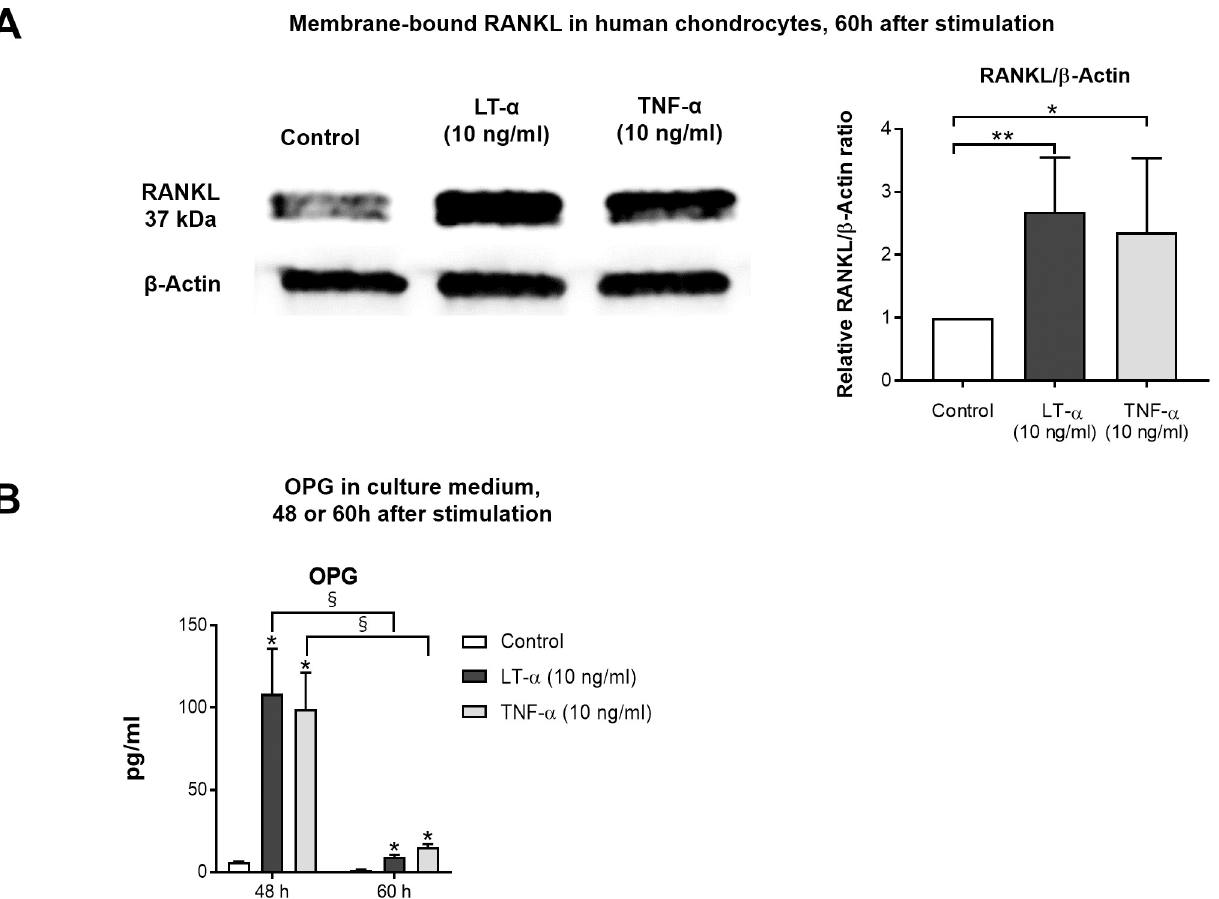
Fig 6. Cytokines induced the expression of RANKL and OPG in human chondrocytes. (A) Membrane–bound RANKL in cells was up–regulated 2.7– fold or 2.4–fold at 60 hours after stimulation with LT– α or TNF– α respectively (n = 5 per experiment group). � p < 0.05, �� p < 0.01. (B) OPG concentrations in culture medium were increased at 48 and 60 hours after stimulation with LT– α or TNF– α compared to the control. However, OPG concentrations in culture medium at 60 hours were markedly decreased compared to those at 48 hours. (n = 6 per experimental group). � /§ p < 0.001.